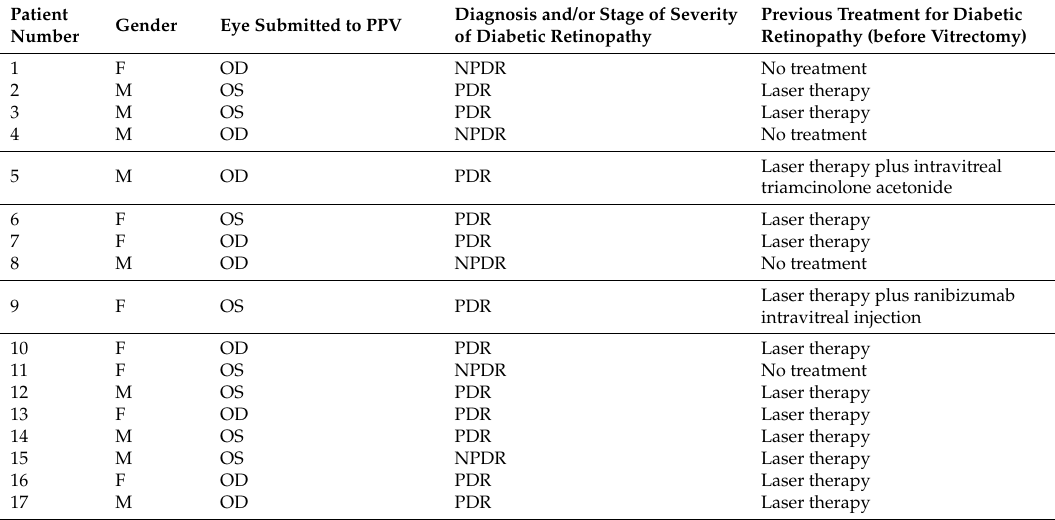
Table 2. Patient baseline clinic, demographic characteristics, and previous